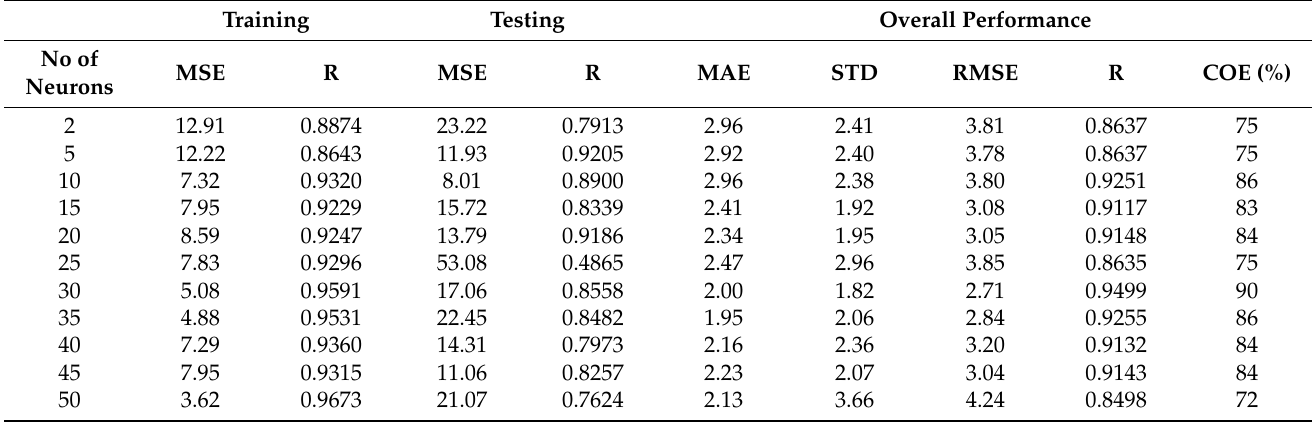
Table 3. Neurons Number impact on MLP Network Predictive Modelling with